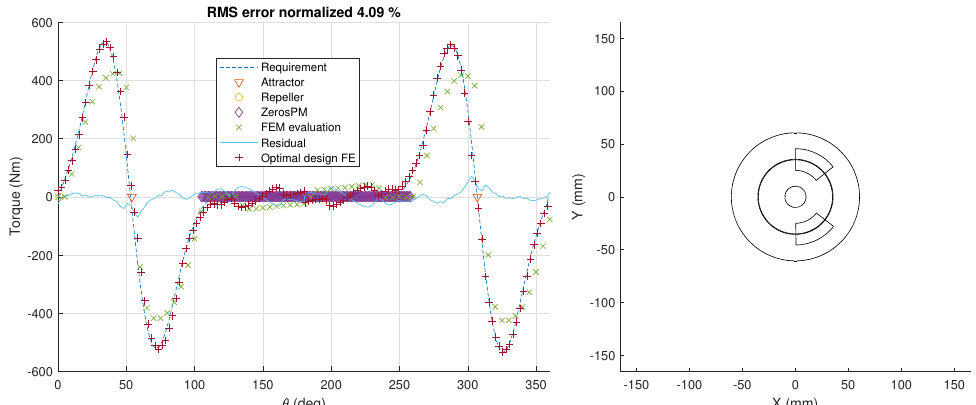
Figure 10. Free shape approach with spline formulation, optimization results for conjugate cam- follower reference torque. Left —FEM torque characteristic calculation, right —initial magnetic spring geometry.